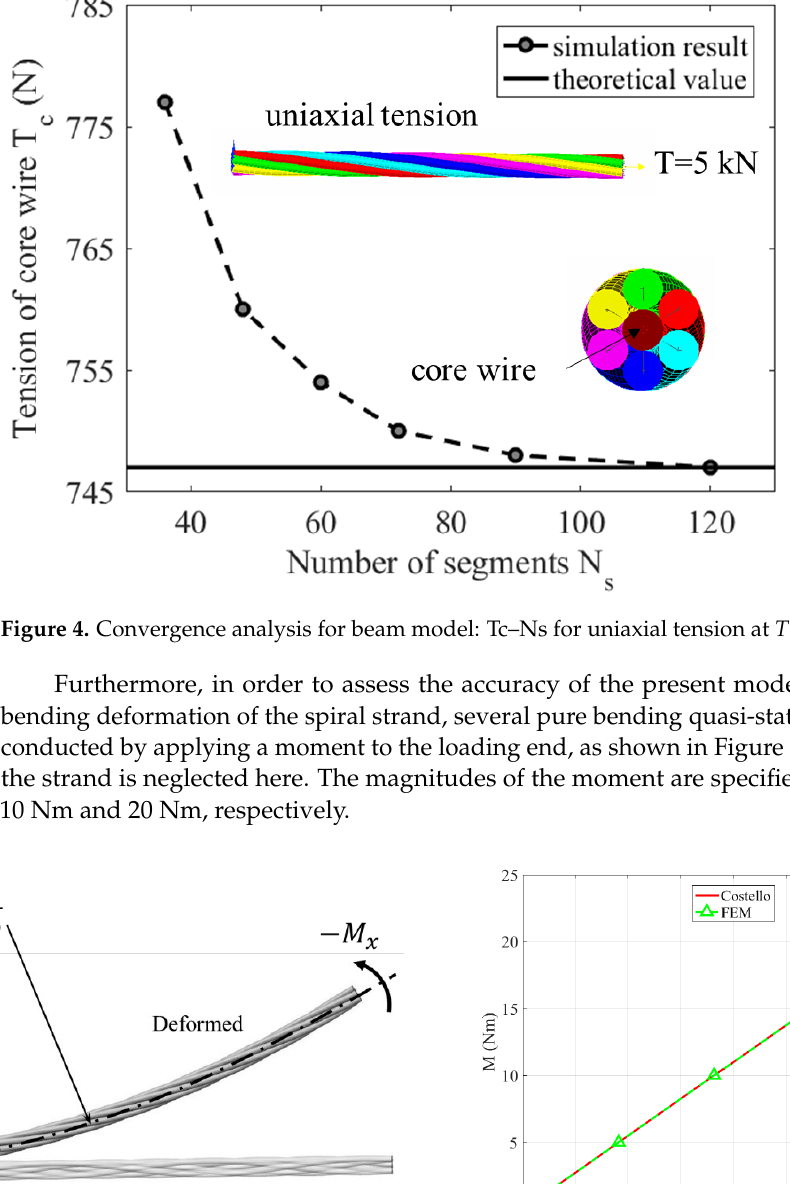
Figure 5. ( a ) Schematic of the pure bending deformation; ( b ) comparison of the bending moment– curvature curves obtained from Costello’s theory and the presented beam FE model.